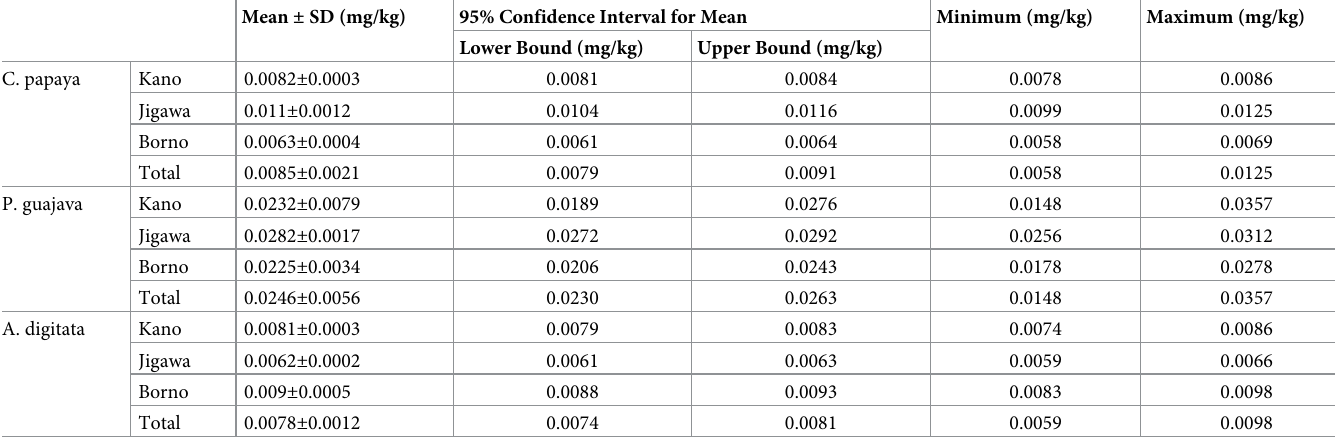
Table 3. Descriptive statistics of the activity concentration of Cr in the medicinal plants from the three states.